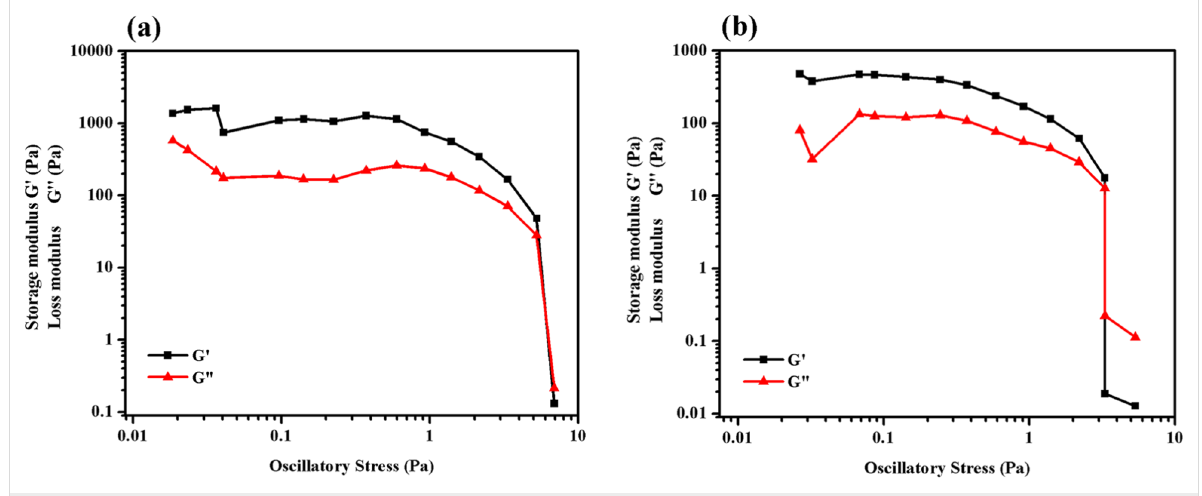
Figure 5: Stress sweep rheological experiment of TPM-G12 gel (1.5% w/v) in (a) propan-1-ol (b) DMSO.